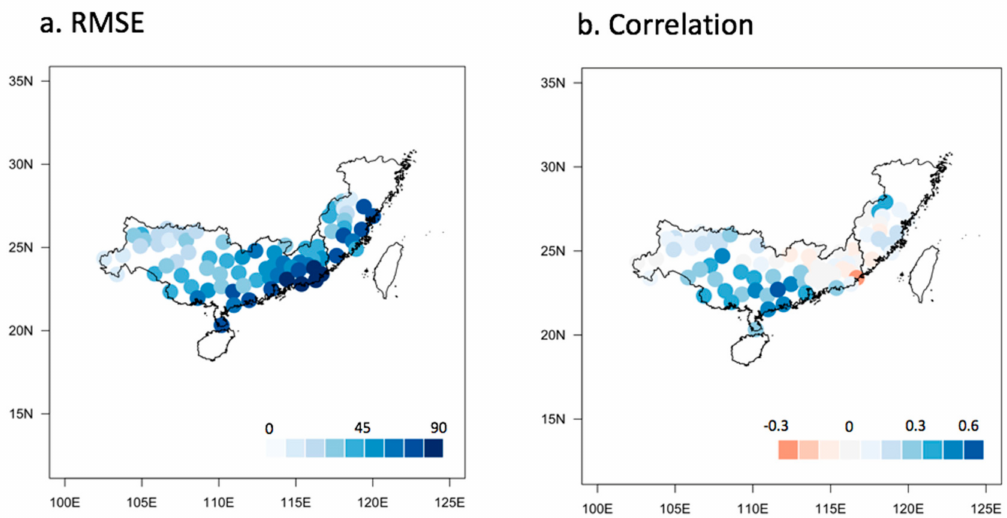
Figure 5. Graphs showing the average RMSE ( a ) and correlation coe ffi cient ( b ) calculated using the prediction model for 55 typhoons at 75 stations during the model training